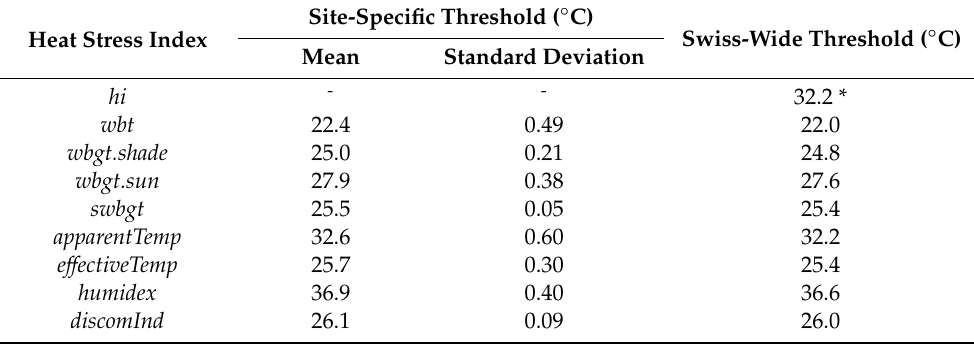
Table 2. Considered heat stress indices with respective mean site-specific (including the spatial standard deviation) and Swiss-wide